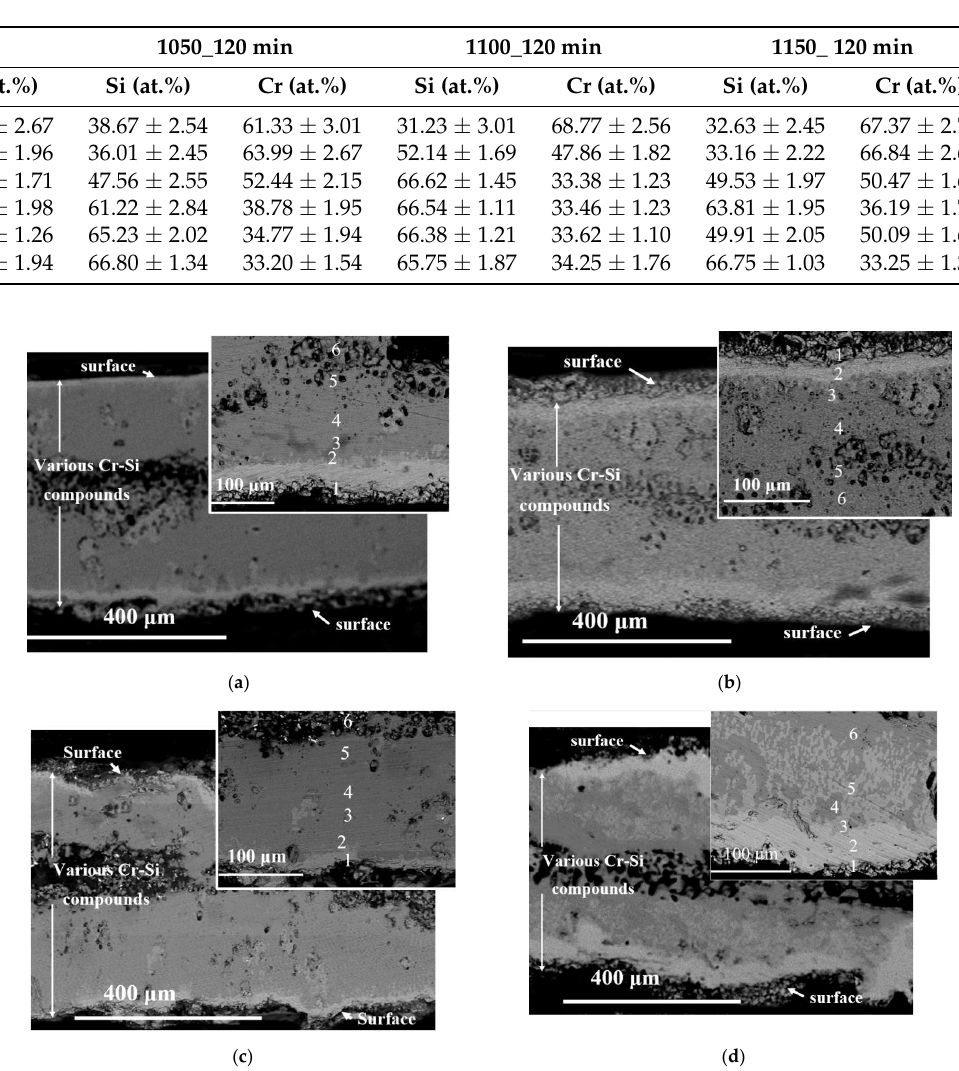
Figure 2. Amount of equilibrium phases formed during pack cementation process as a function of the Si amount.